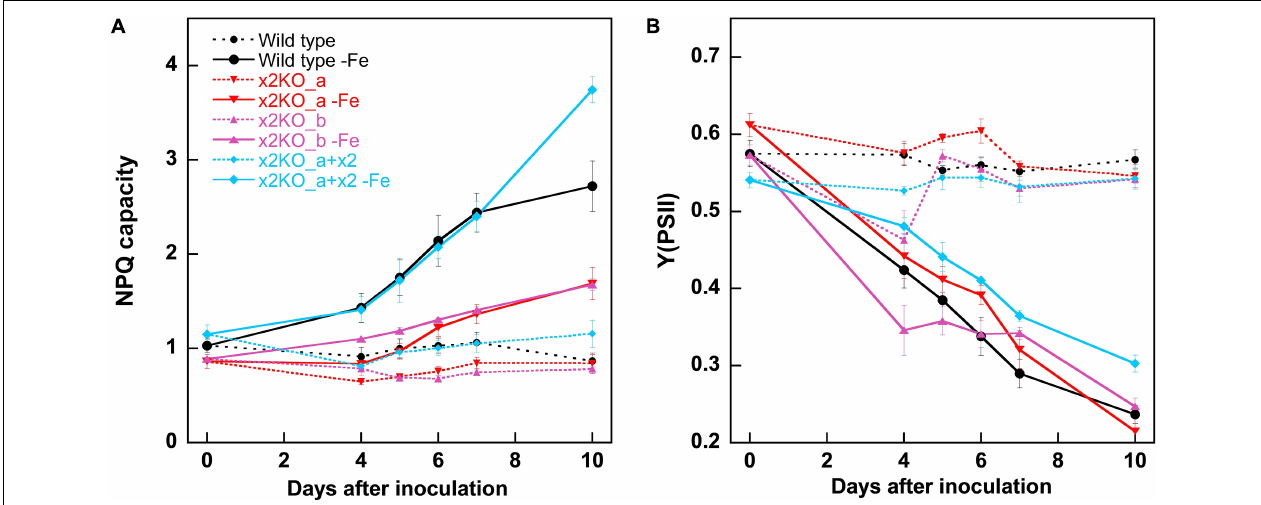
FIGURE 3 | Non-photochemical fluorescence quenching (NPQ) capacities (A) and Y (PSII) (B) within 10 days after transfer of Phaeodactylum tricornutum wild type and mutant strains to an iron-depleted medium. For NPQ measurements, cells were exposed to ∼ 500- µ mol photons m − 2 s − 1 of blue light in an Imaging-PAM. Mean values are derived from three to six independent replicates. SE is